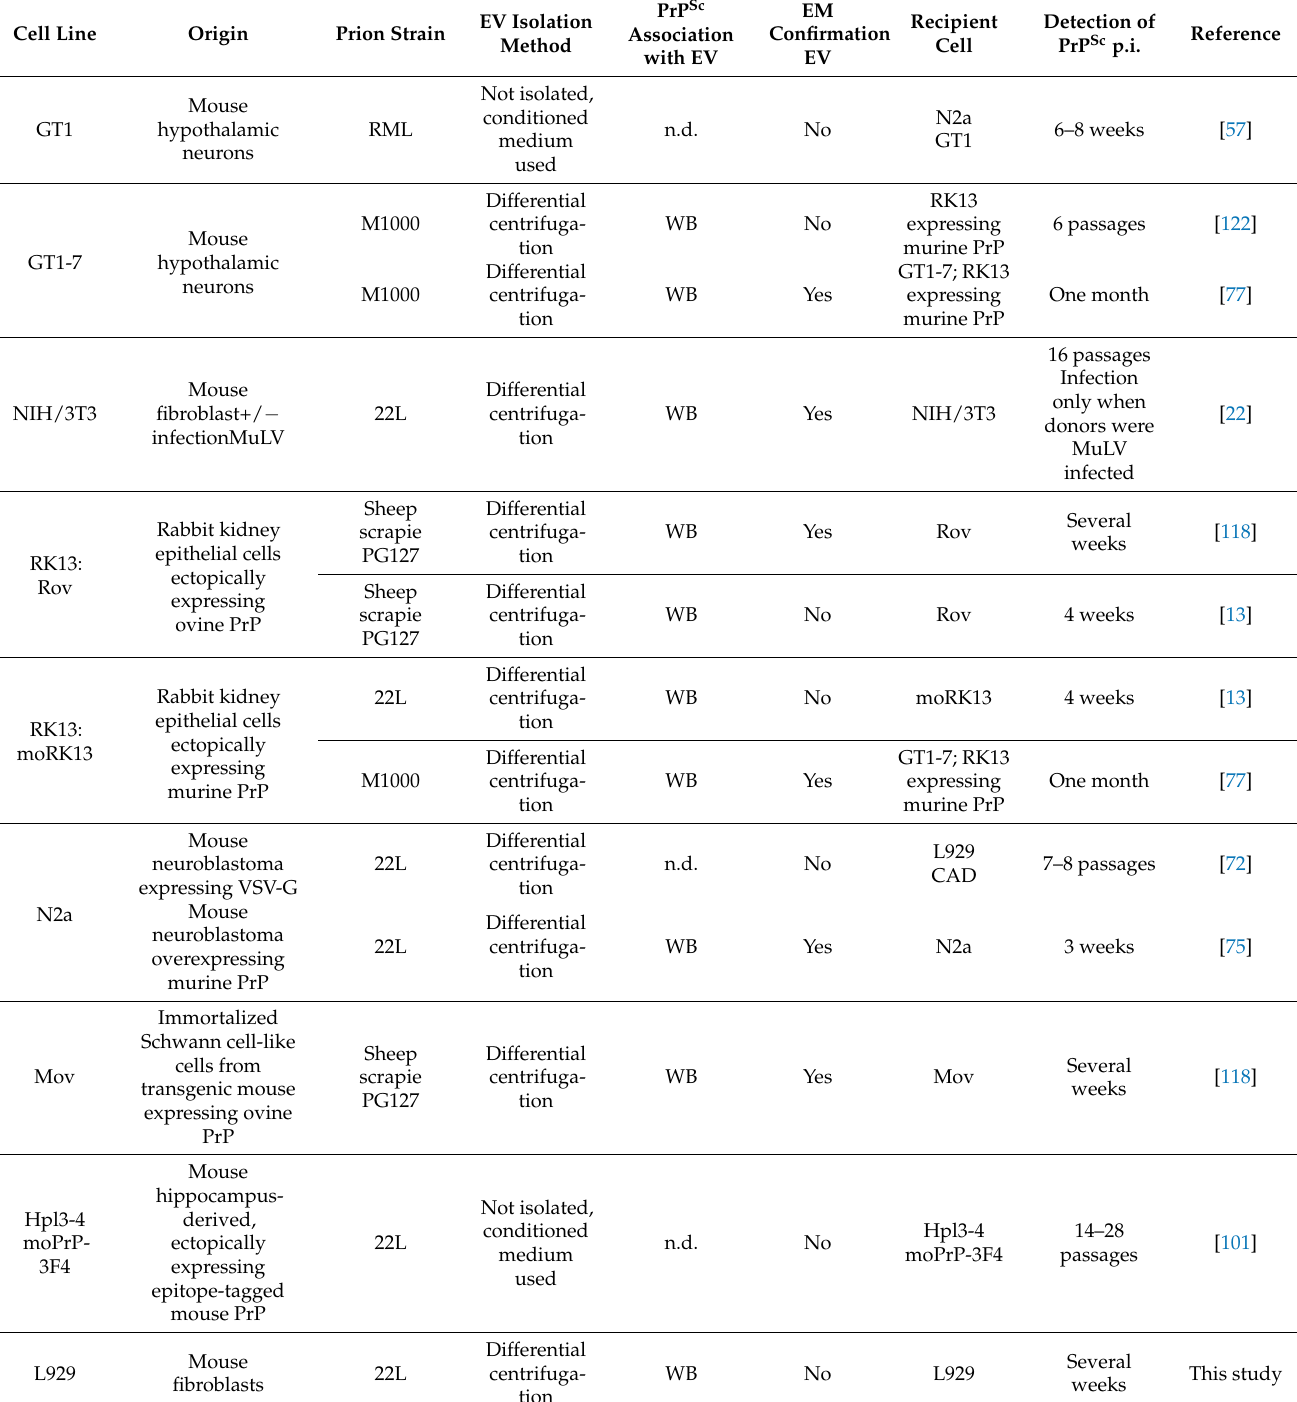
Table 2. Cell lines secreting prion